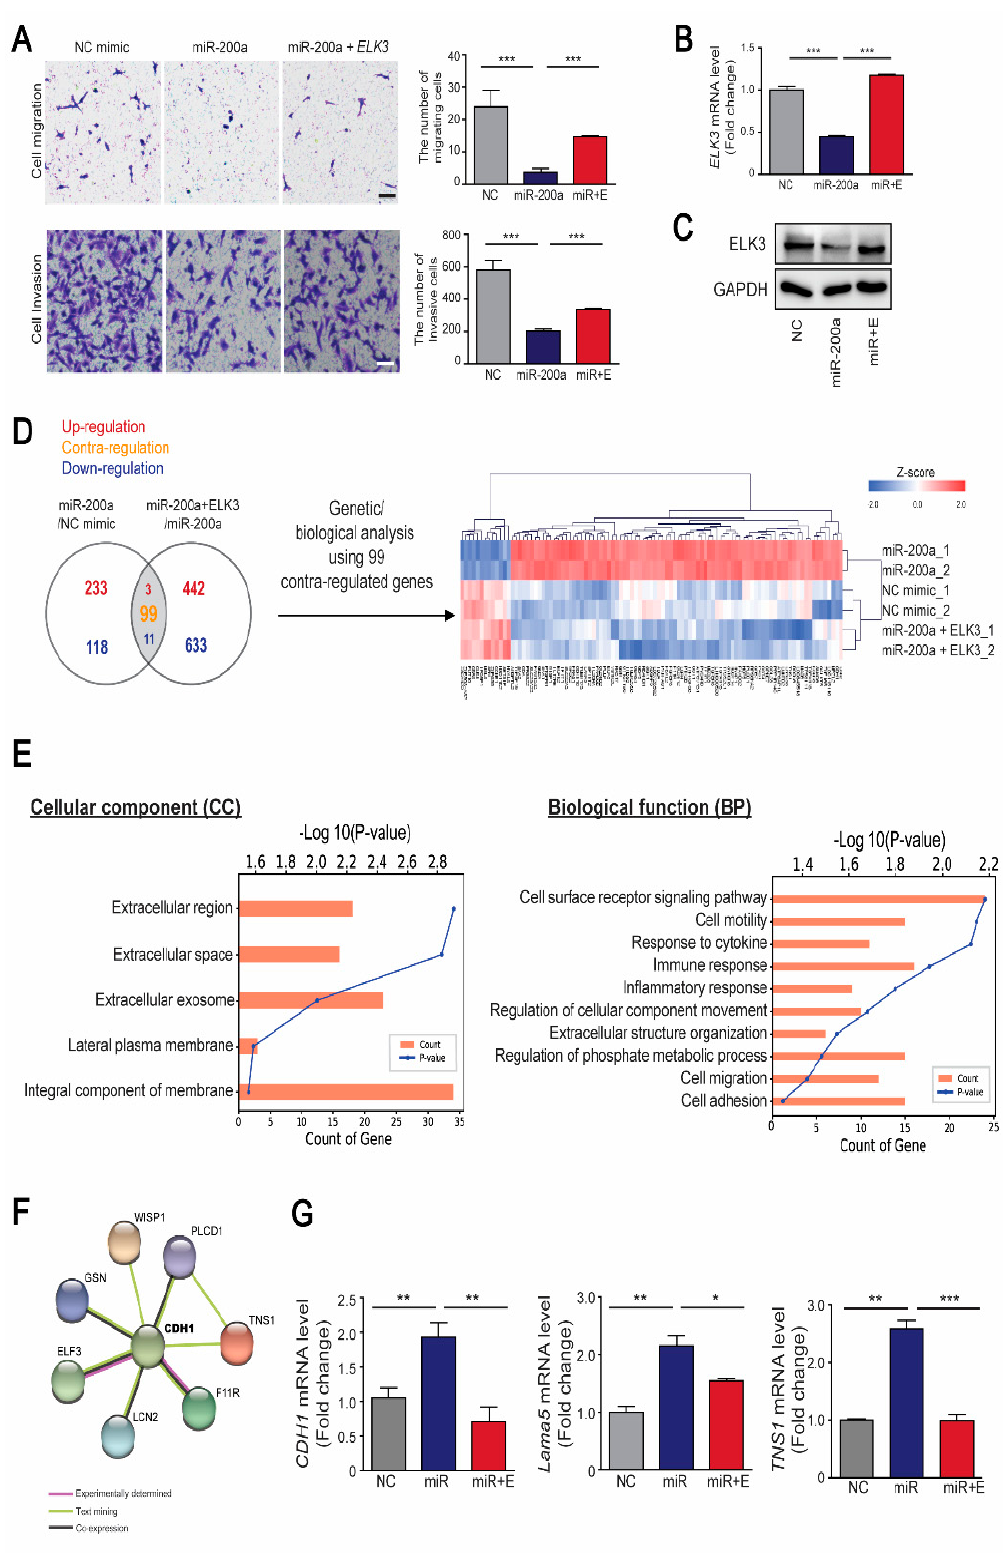
Figure 5. The miR-200a / ELK3 axis regulates the invasion and migration of TNBC cells in vitro. ( A ) Representative images showing the cell migration and invasion of MDA-MB 231 cells expressing a negative control (NC) mimic, miR-200a (100 nM), or miR-200a (100 nM) plus pcDNA3.1-Flag- ELK3 (30 ng). The graph indicates quantified cell migration and invasion. Migrating and invasive cells